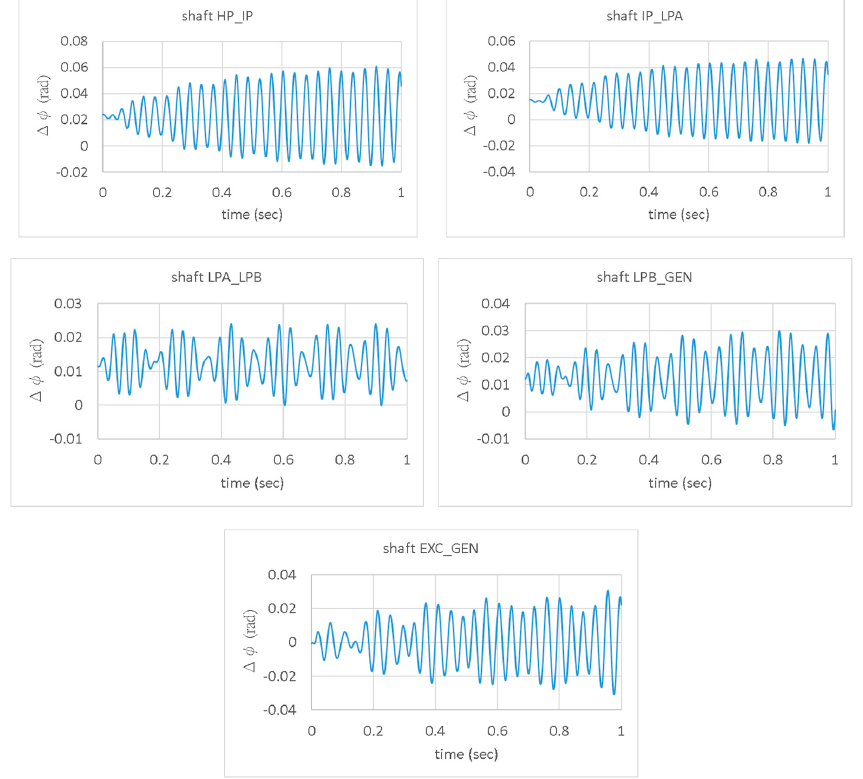
Figure 12. Shaft torsional responses for the integration of a 100 MW DFIG wind farm under the compensation of Bc = 0.0135 S.